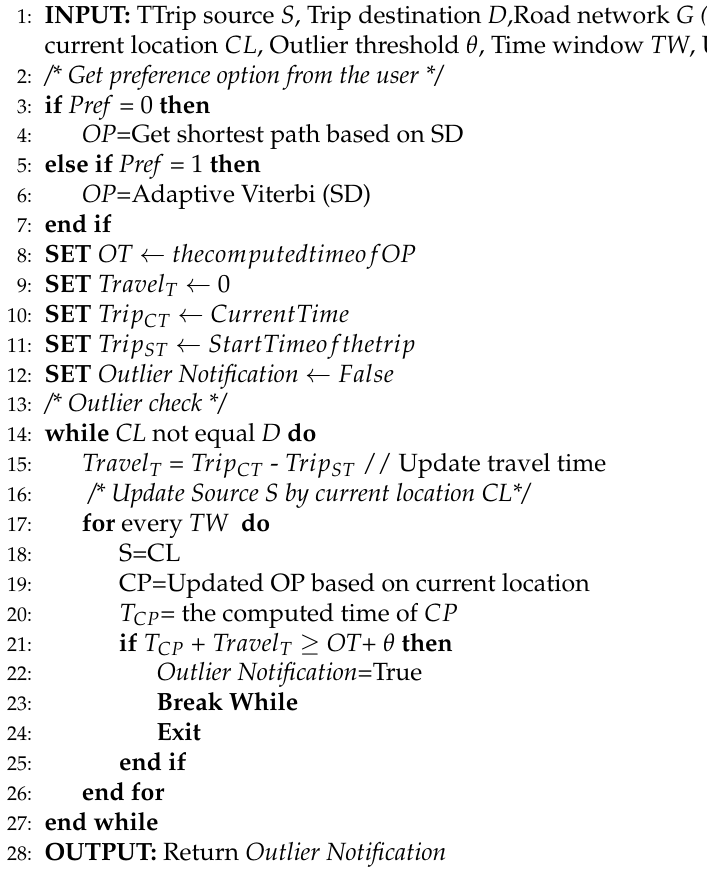
Algorithm 2 FraudMove: Real-Time Trajectory Outlier